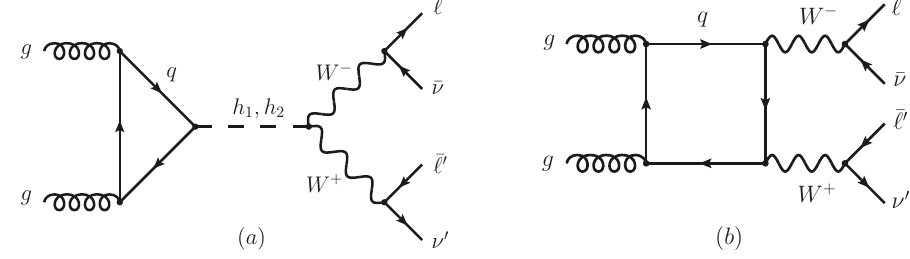
h ; h WW 4 leptons in the SM 1 2 g ) ! ! f !